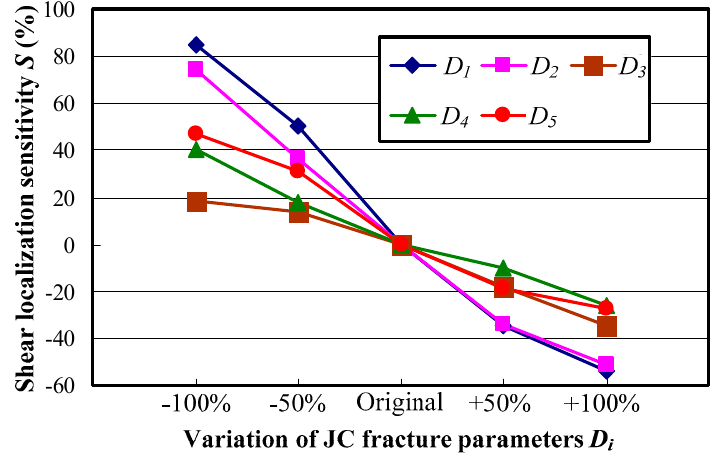
Figure 11. Influences of material fracture parameters on chip shear localization for Inconel 718.